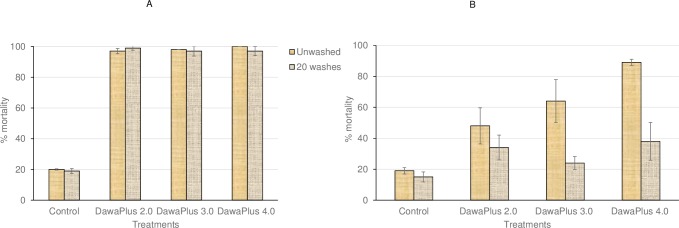
Mortality of adults of An. gambiae Kisumu (A) and An. gambiae s.l. (emerged from field-collected larvae) (B) in tunnel tests with different treatments. Bars show mortality rates of unwashed and 20-times washed nets in different treatments. Error bars represent 95% confidence intervals.